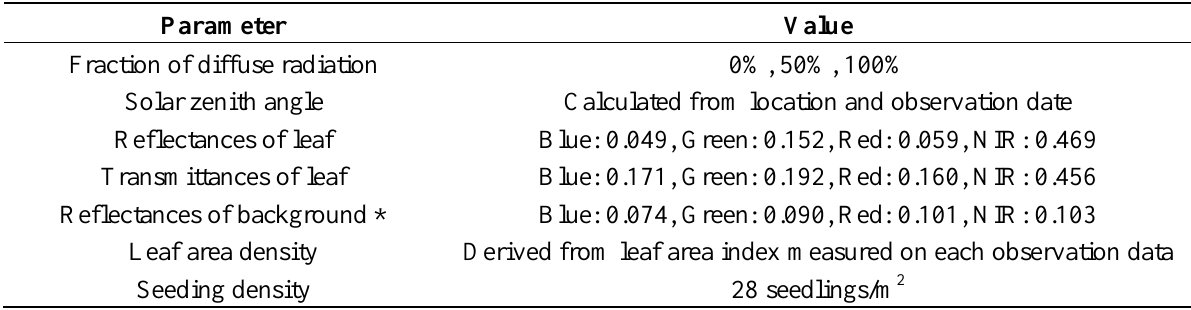
Table 2. Parameters used for Forest Light Environment Simulator